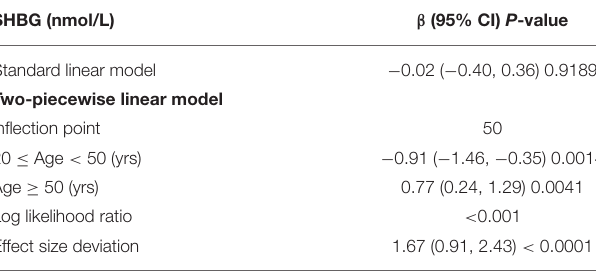
TABLE 5 | Threshold effect analysis of age on SHBG level in adult females using the two-piecewise linear regression